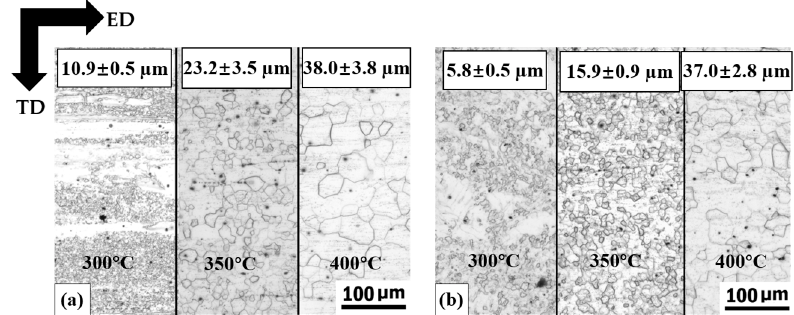
Figure 5. Optical microscope images of ( a ) as-extruded; and ( b ) ECAPed (1-pass) alloys at different annealing temperatures for 60 min.